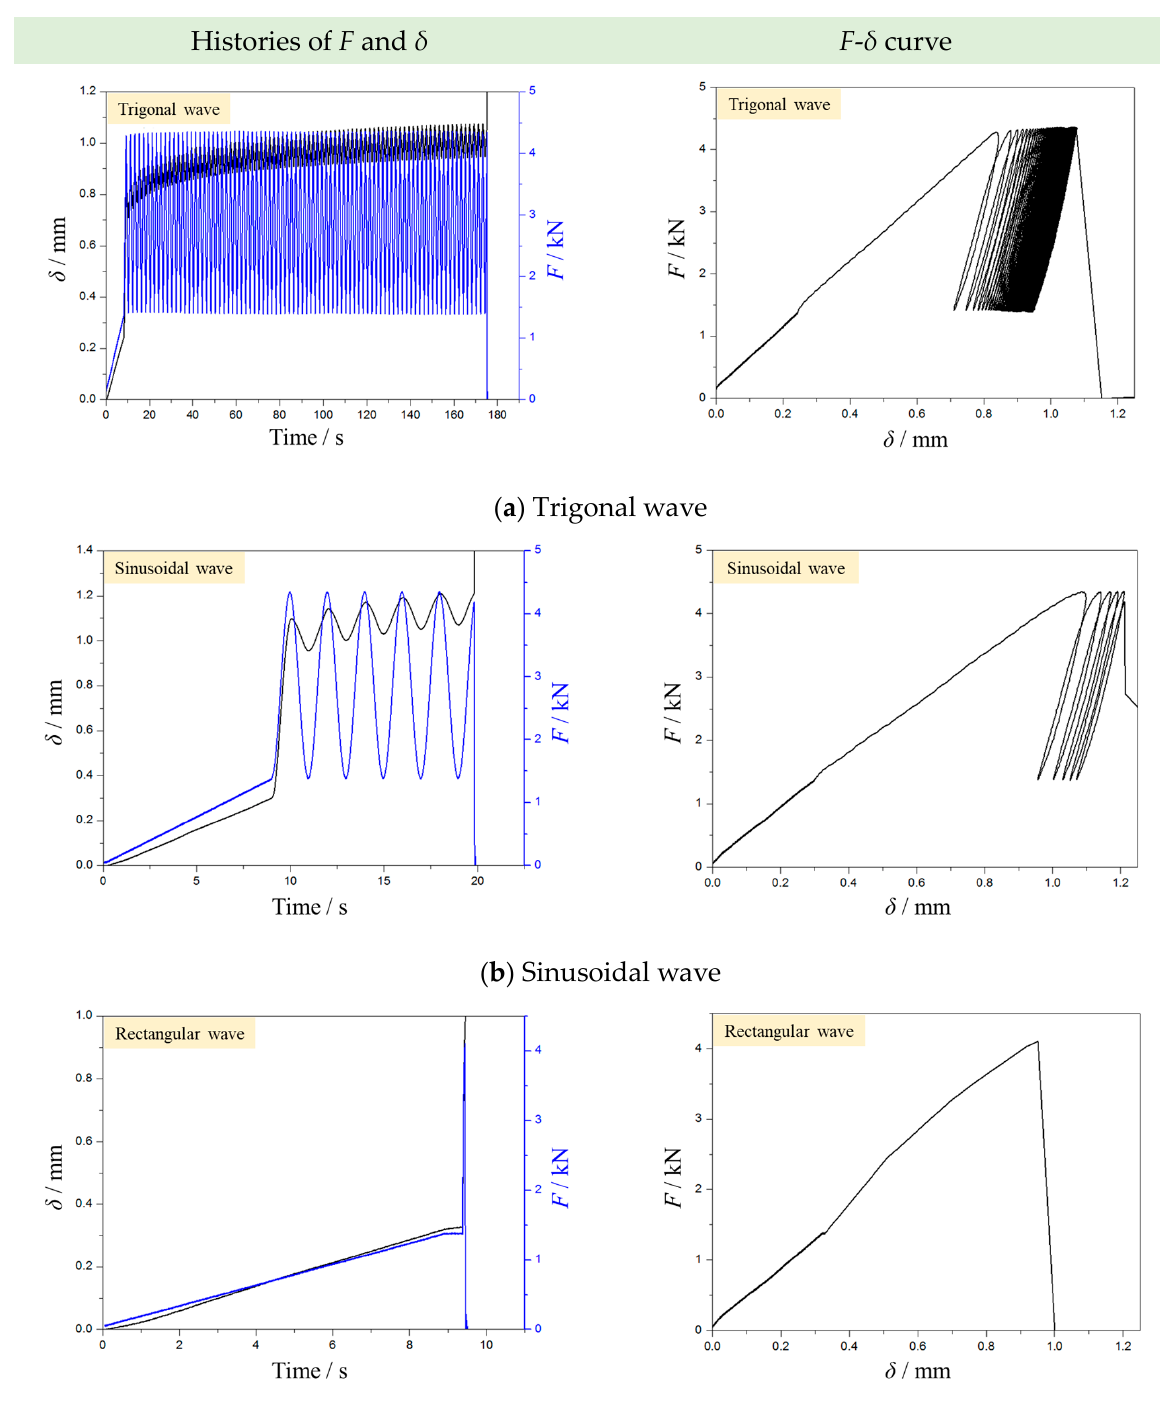
Figure 9. Typical curves of load and indentation depth in CPL tests with ( a ) trigonal, ( b ) sinusoidal, and ( c ) rectangular waves (the left column shows the histories of F and δ , and the right column shows the F - δ curves).